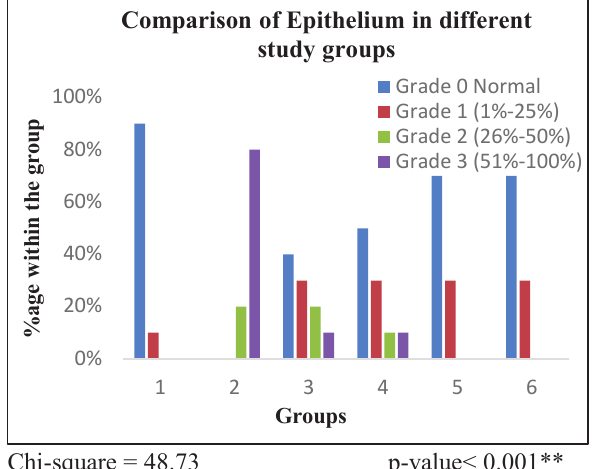
Graph 2: Comparison of Epithelium in different study